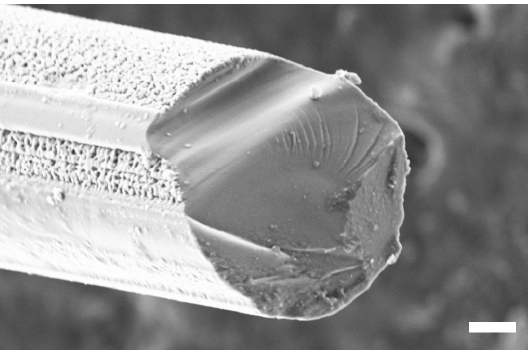
Figure 11. Fibre cross-section of glass 18-06 after 14 days storage in SBF (scale bar 2µm).